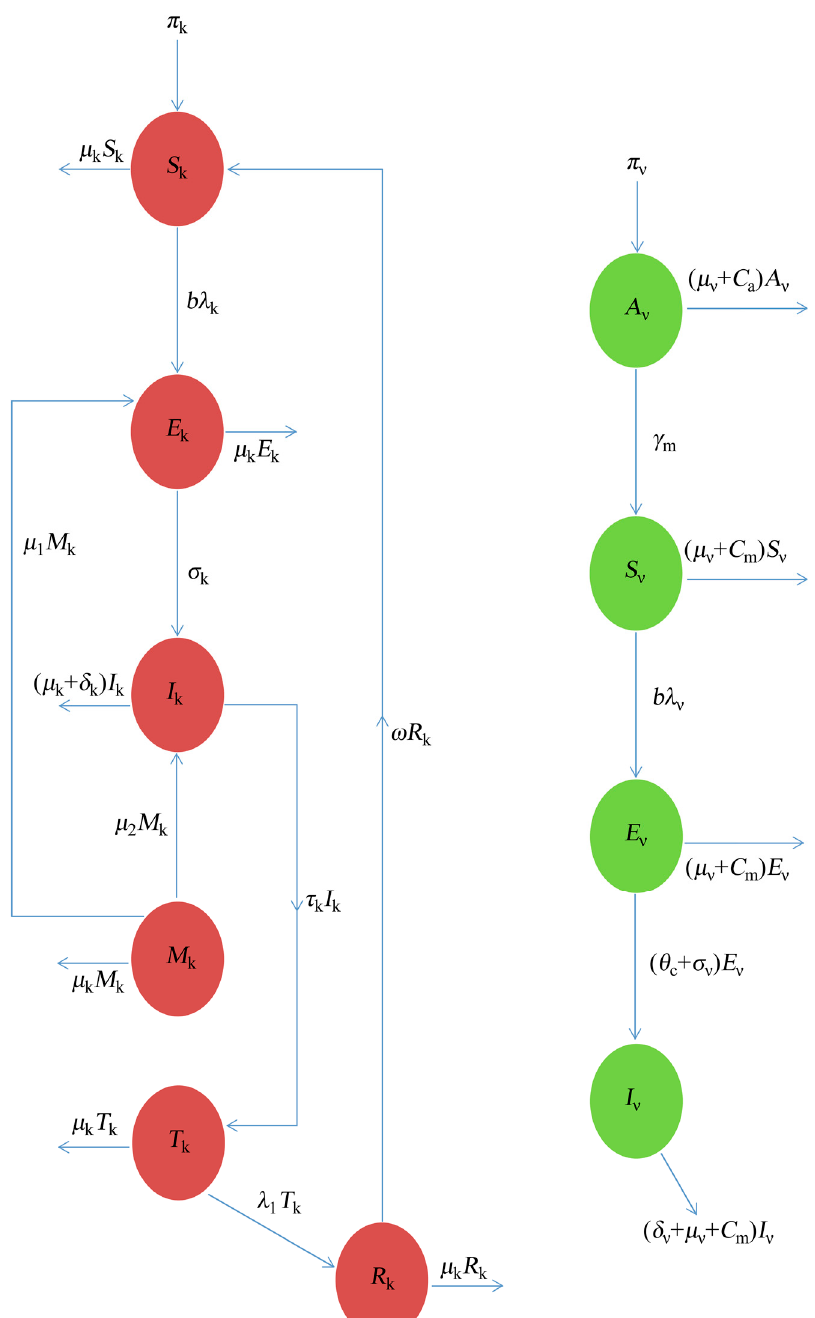
Figure 1. The schematic illustration of the Dengue model.